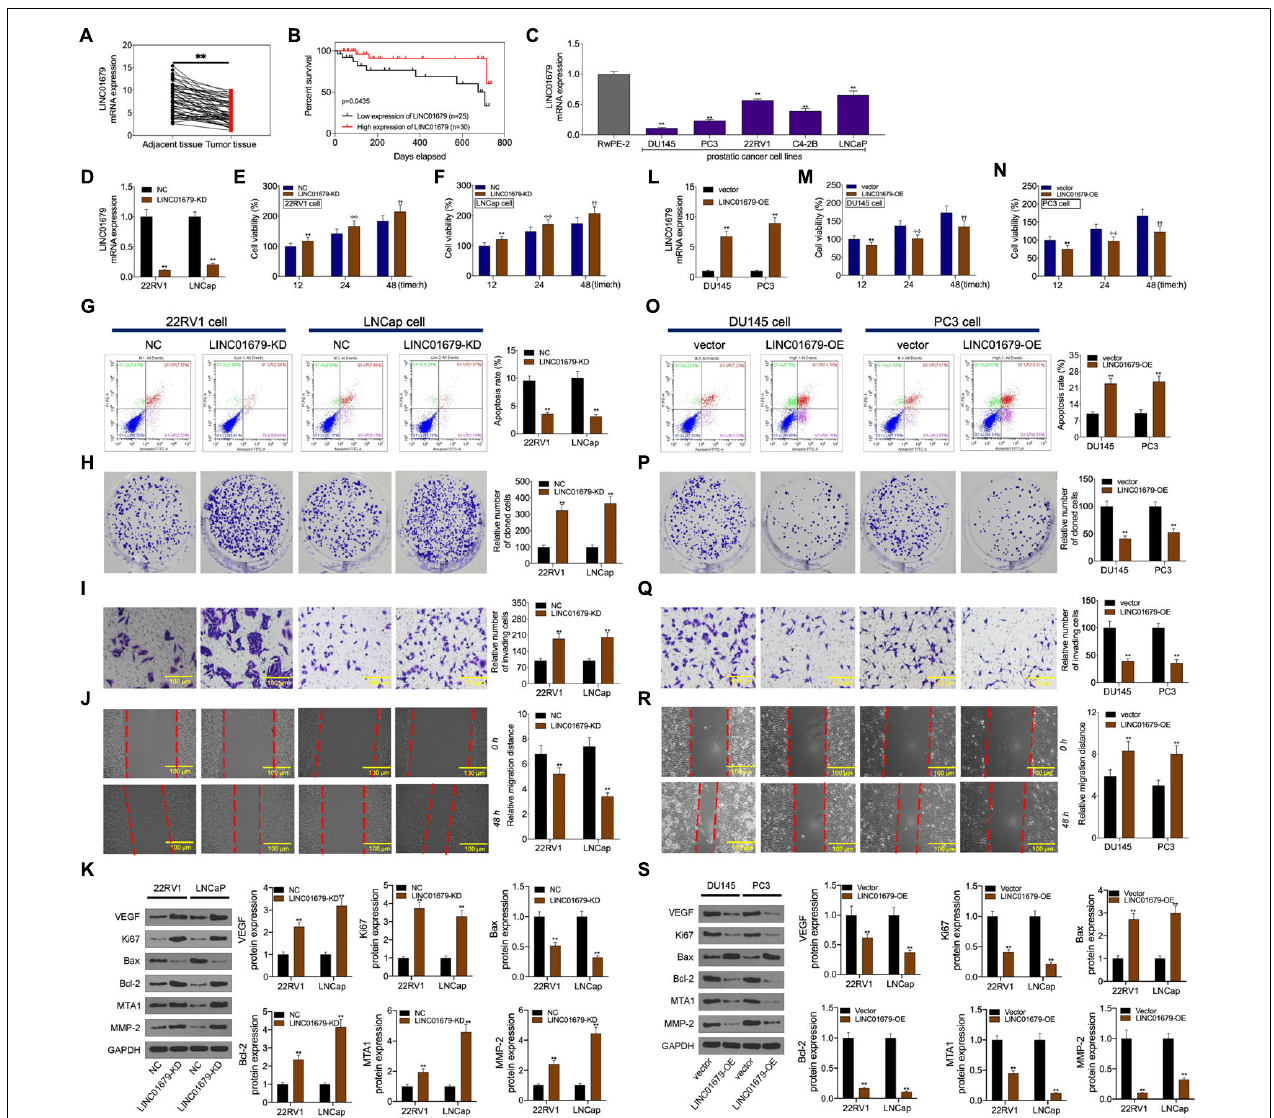
FIGURE 3 | LINC01679 regulated cell proliferation, apoptosis, migration, and invasion in vitro. (A) qRT-PCR assay was conducted to detect LINC01679 expression in PCa patients. (B) KM survival analysis on high and low LINC01679 expression. (C) LINC01679 levels within PCa cells measured by qRT-PCR assay. LINC01679 expression (D,L) , cell viability (E,F,M,N) , cell apoptosis (G,O) , proliferation (H,P) , invasion (I,Q) , migration (J,R) , and protein expression of VEGF, Ki67, Bax, Bcl-2, MTA1, and MMP-2 (K,S) of cells transfected with siRNA-LINC01679 or LINC01679-expressing vector determined by qRT-PCR, CCK-8, flow cytometry, colony formation, Transwell, scratch, and WB assays. The experiment was repeated thrice independently; ** vs. NC or vector group, p < 0.01; (cid:67)(cid:67) vs. vector at 24 h group; †† vs. vector at 48 h